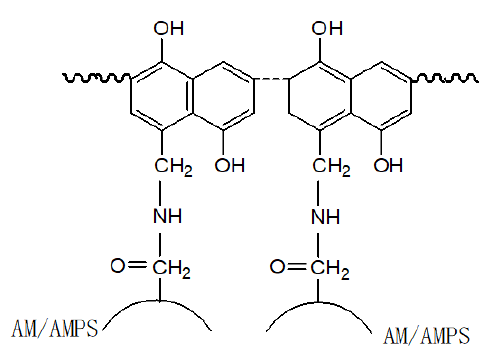
Figure 1. Schematic Diagram of Gel Structure.